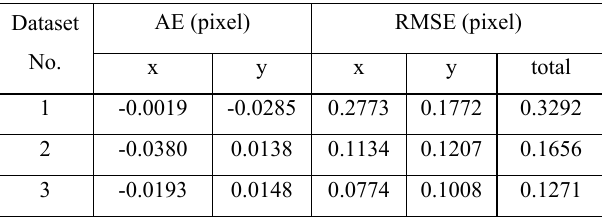
Table 3. B2-B3 registration